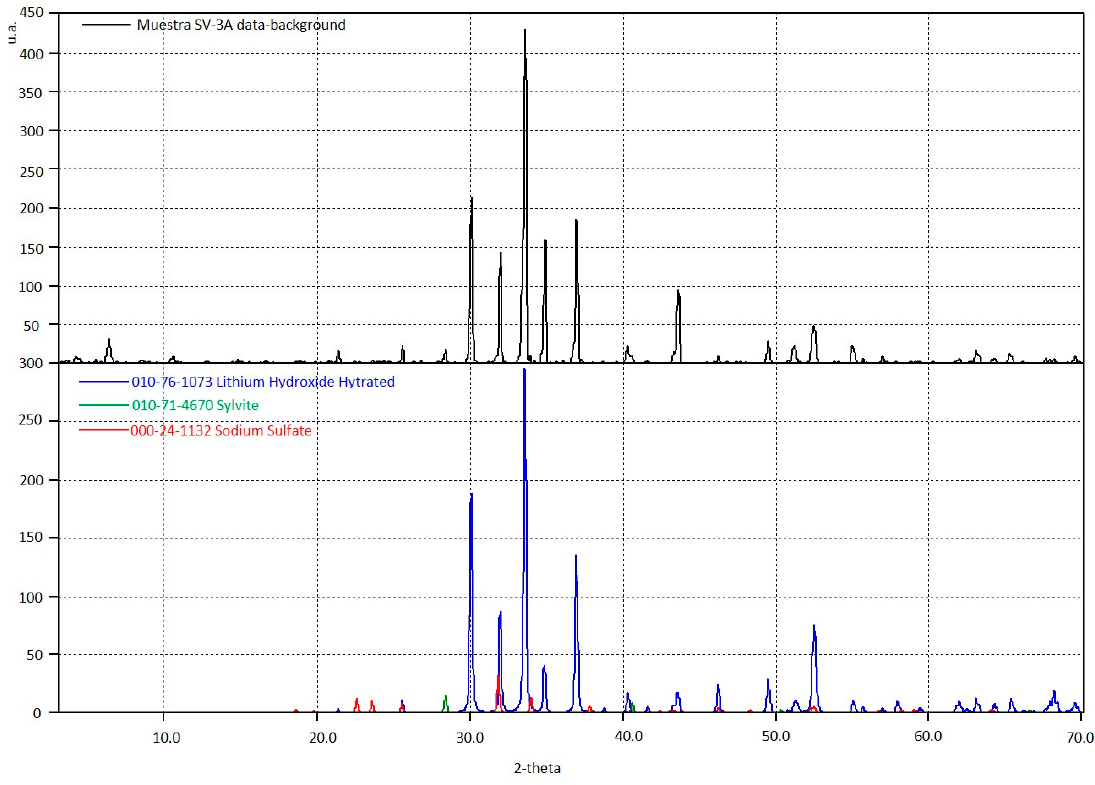
Table 4. Solid product chemical analysis for all experiments, in wt%.